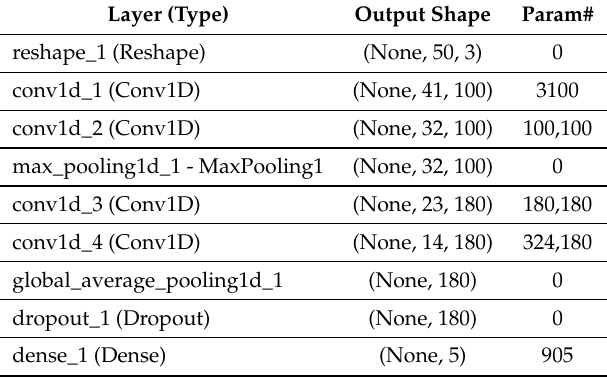
Table 2. 1D-CNN’s hyper-parameters to classify activities.